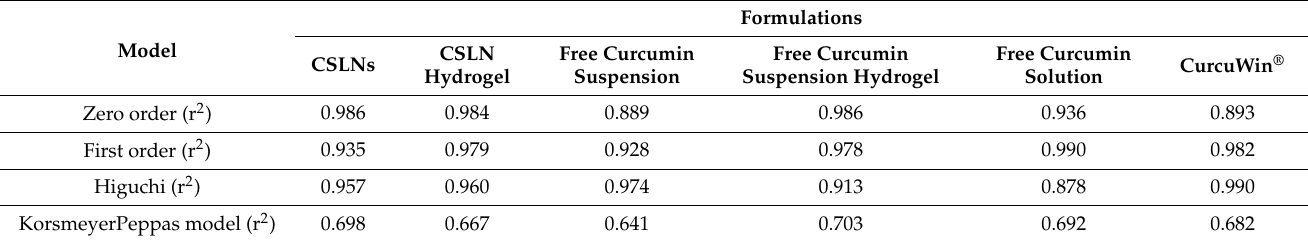
Figure 5. Cumulative % curcumin release from various formulations. CSLN-H—CSLNs hydrogel; FC—Free curcumin; FC-H- Free curcumin hydrogel. Table 9. Drug release